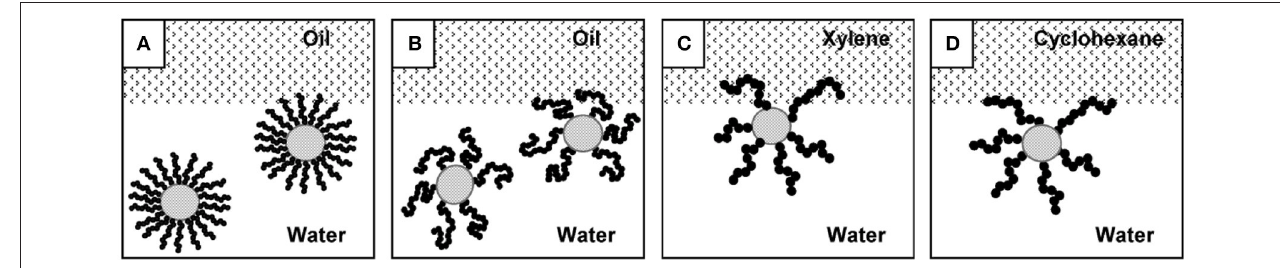
FIGURE 8 | Effect of grafting density and the solubility of the grafted polymer chain in oil and water phases on the location of the hybrid silica nanoparticles (Saigal et al., 2010). Particles with high grafting density (A) are restricted in their ability to reorganize and penetrate the interface compared to particles with a low grafting density (B) . Proposed configurations of a SiO 2 -PDMAEMA particle at an oil/water interface, with chains able to penetrate xylene (C) , but not cyclohexane (D) . Reprinted with permission from Saigal et al. (2010). Copyright 2010 American Chemical